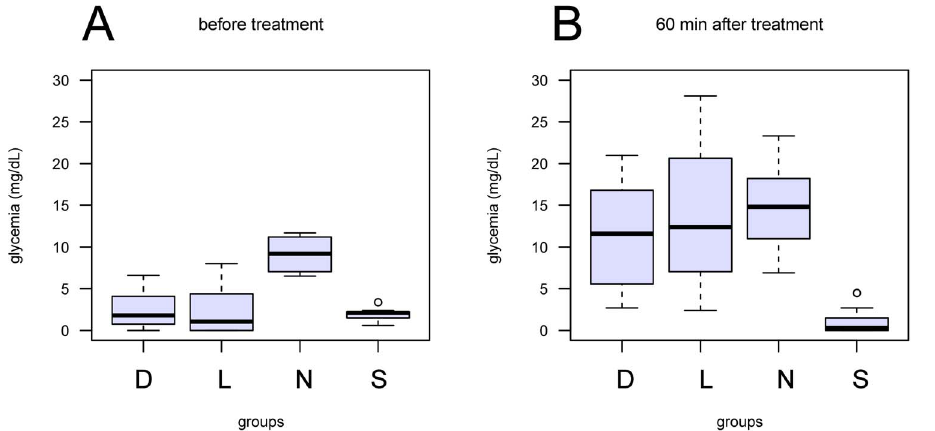
Figure 1. Box plot of the glycemia values obtained in the four groups S – sham injected, N – intact, L – L-cHH-injected, D- D-cHH- injected at the beginning of the experiment and before sacrifice, one hour post-injection.